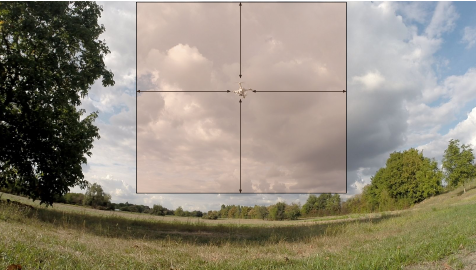
Figure 20. Random cropping of an image patch/tile during training. In most cases (80% of the time), the crop location is sampled to contain at least one drone. The rectangle in the image shows the area covered by the possible crop locations for this drone.